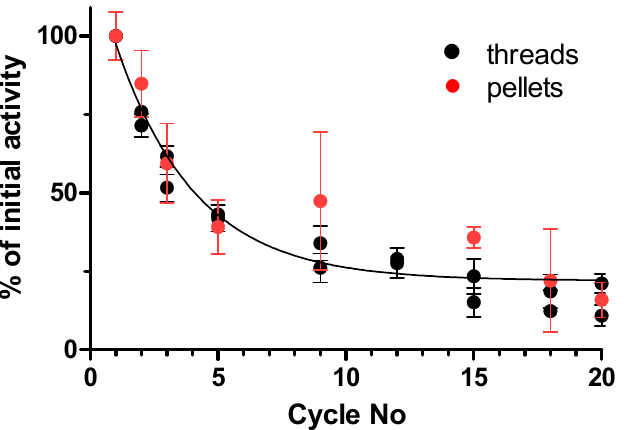
Figure 5. The reusability of immobilized pectinase onto nylon 6/6 threads and beads during 20 successive cycles.